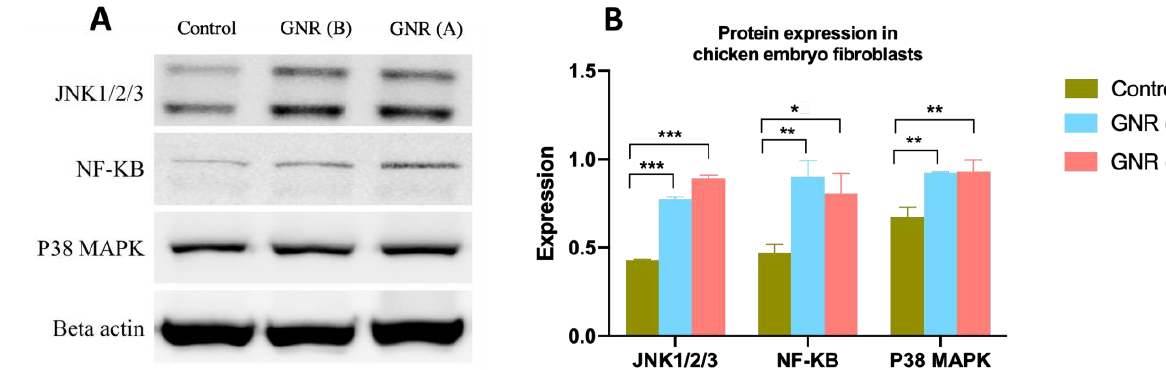
Figure 6. Western blot ( A ) and quantification of bands ( B ) of the expression of JNK 1/2/3, NF-KB p65, and P38 MAPK in cultured chicken embryonic fibroblasts upon treatment with GNR (A) and (B). The results revealed a significant increase in the expression of these key regulatory factors of apoptosis and autophagy signaling pathways. Data are represented as mean ± SD, * p < 0.05, ** p < 0.01, *** p < 0.001.